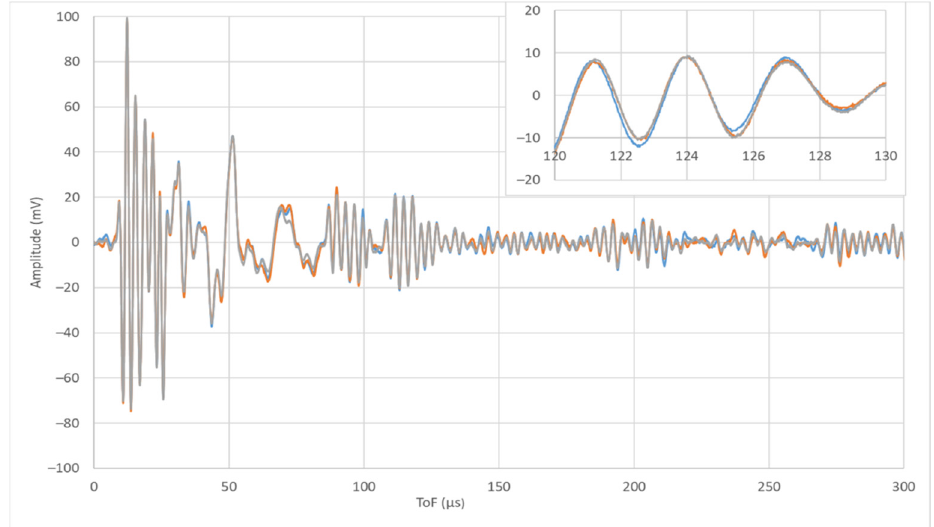
Figure 5. Repeatability of the ultrasound tests and dispersion of the acquired signals (50 ns and 3 mV). General and detailed views.